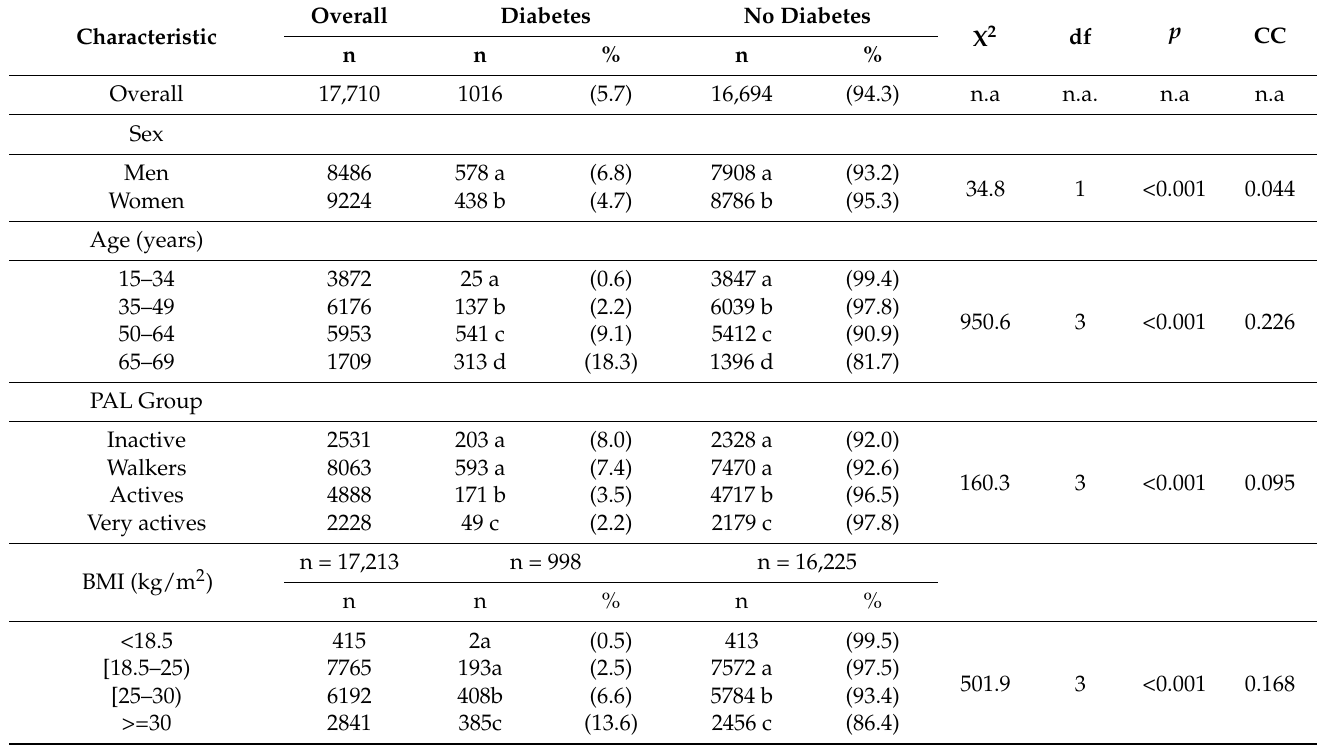
Table 1. Population Characteristics by their Diabetes Prevalence in the ENSE2017.